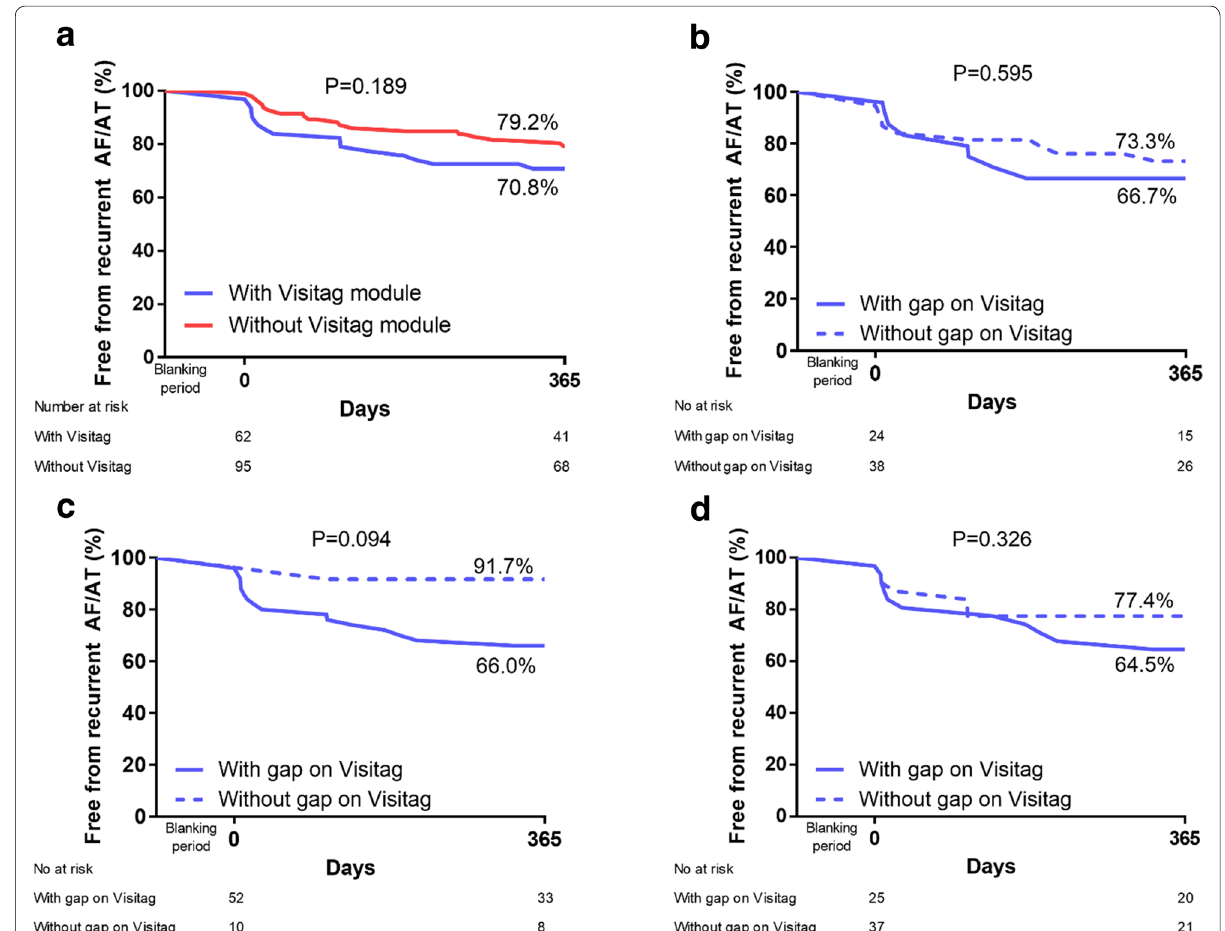
Fig. 4 Comparison of 1‑year atrial fibrillation and tachycardia recurrence‑free survival rates between ablation with and without VISITAG use ( a ), with or without VISITAG gap using Criterion 1 ( b ), and with or without VISITAG gap using Criterion 2 ( c ), and with or without VISITAG gap using Criterion